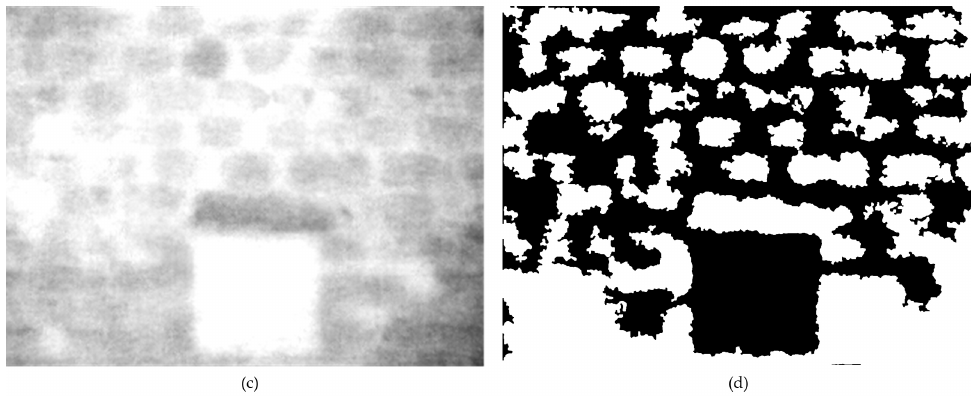
Figure 12. ( a ) Portion of the fresco under investigation, ( b ) highlighting of colours of different gradation, ( c ) thermal image with improved contrast, ( d ) final binary image (see the cones of visions 6 and C in Figure 2).